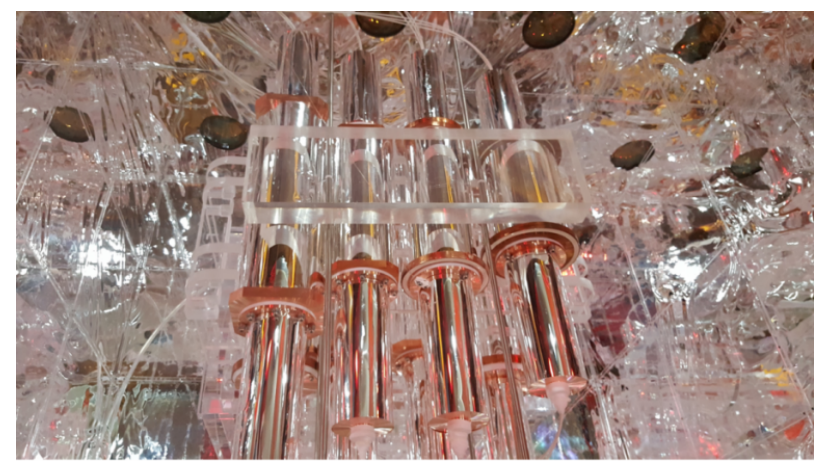
Figure 28: The COSINE-100 detector. Photograph courtesy of the COSINE-100 Col-